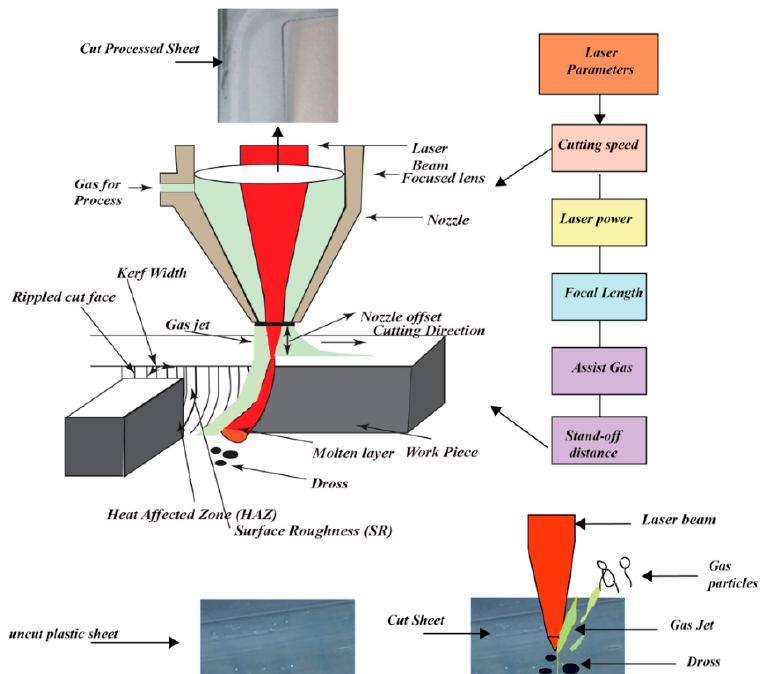
Figure 9. Detailed representation of the process of CO 2 laser cutting, cutting variables, and output responses.